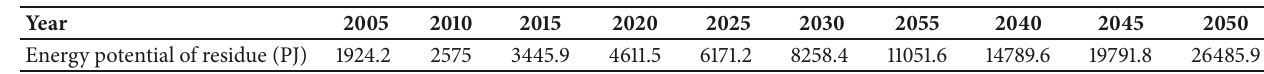
Table 4: 5-yearly estimate energy potential of agro-residues through 2050.